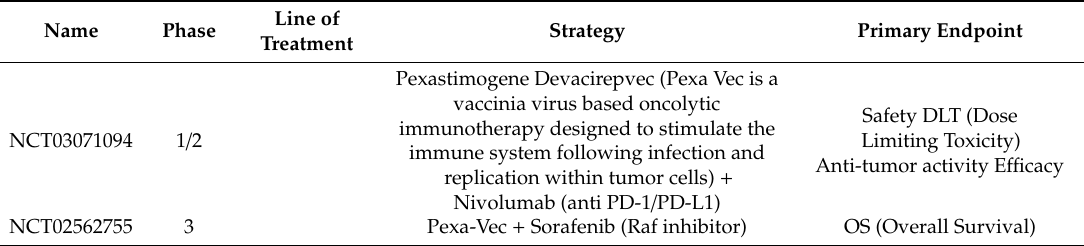
Table 6. Major trials in HCC involving oncolytic viruses-based